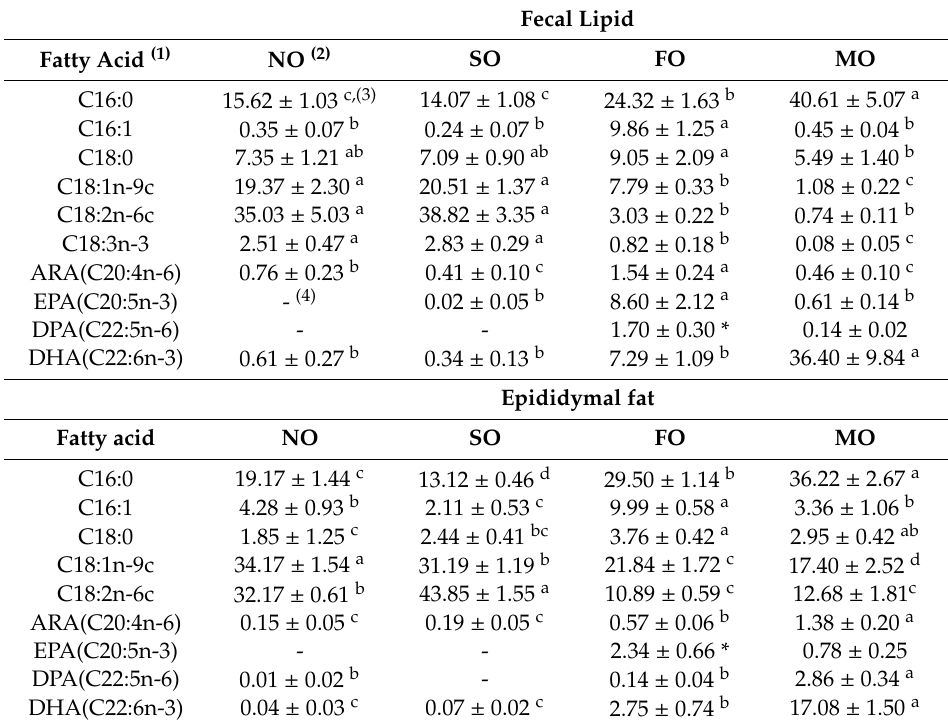
Table 4. The fatty acid composition distributed in fecal lipid and epididymal fat of mice. Fecal